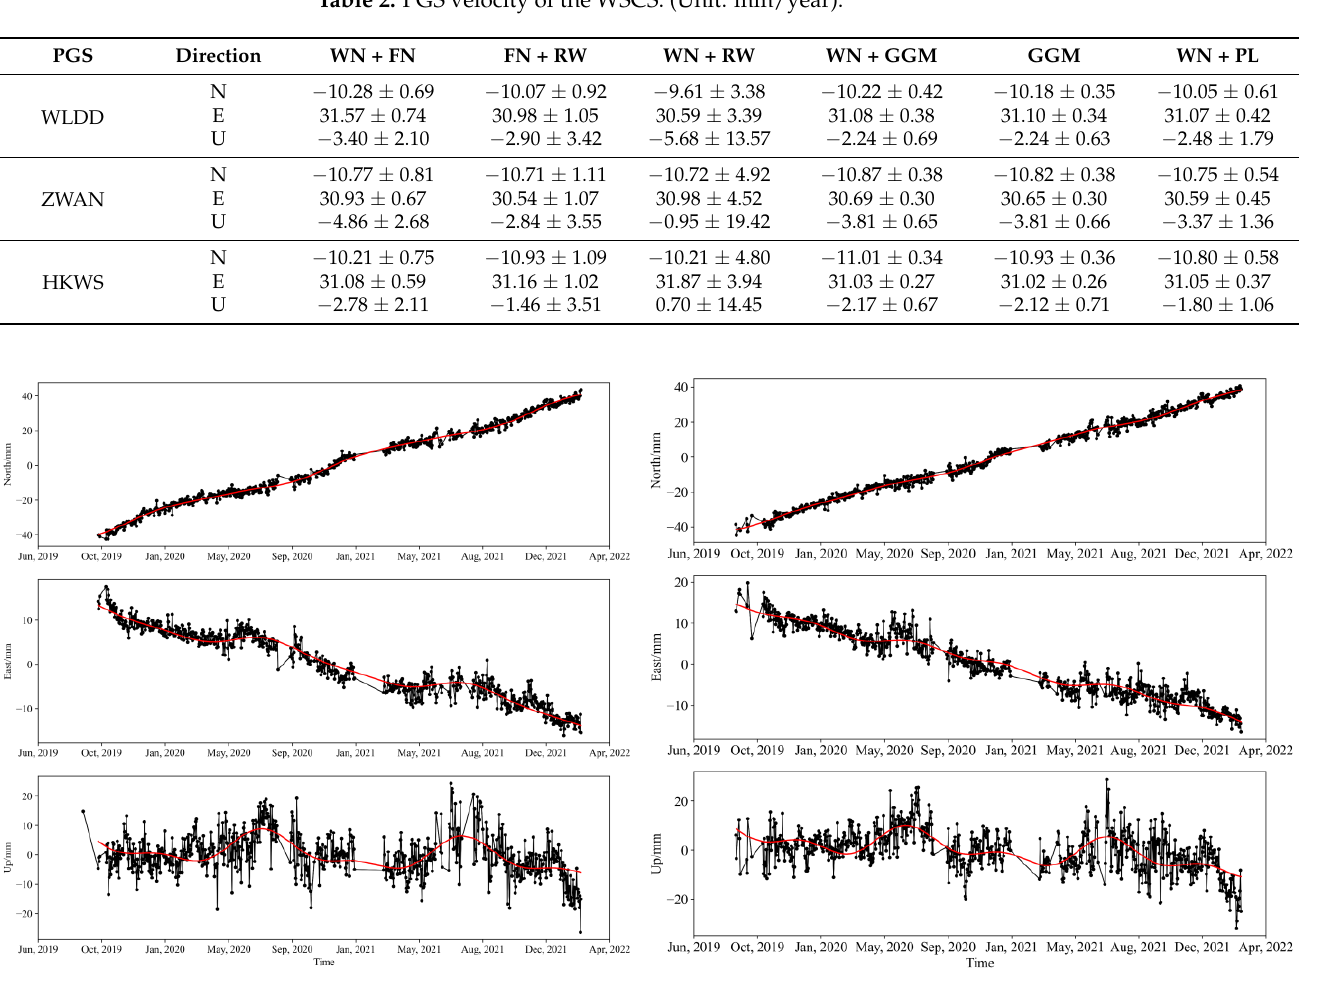
Figure 8. Trend of the WLDD ( left ) and ZWAN ( right ) PGSs in the N, E, and U directions. The red curves represent the change of each direction after geometric modelling.